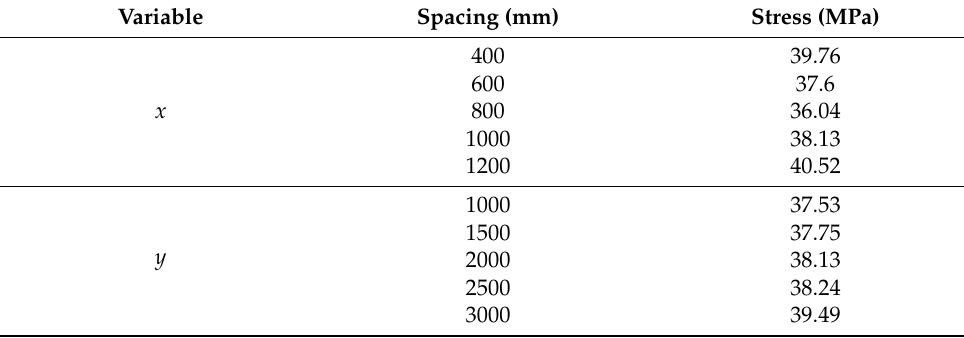
Figure 14. Layout of the pipe support of the compressor outlet pipe. Table 6. Pipe stress under different support